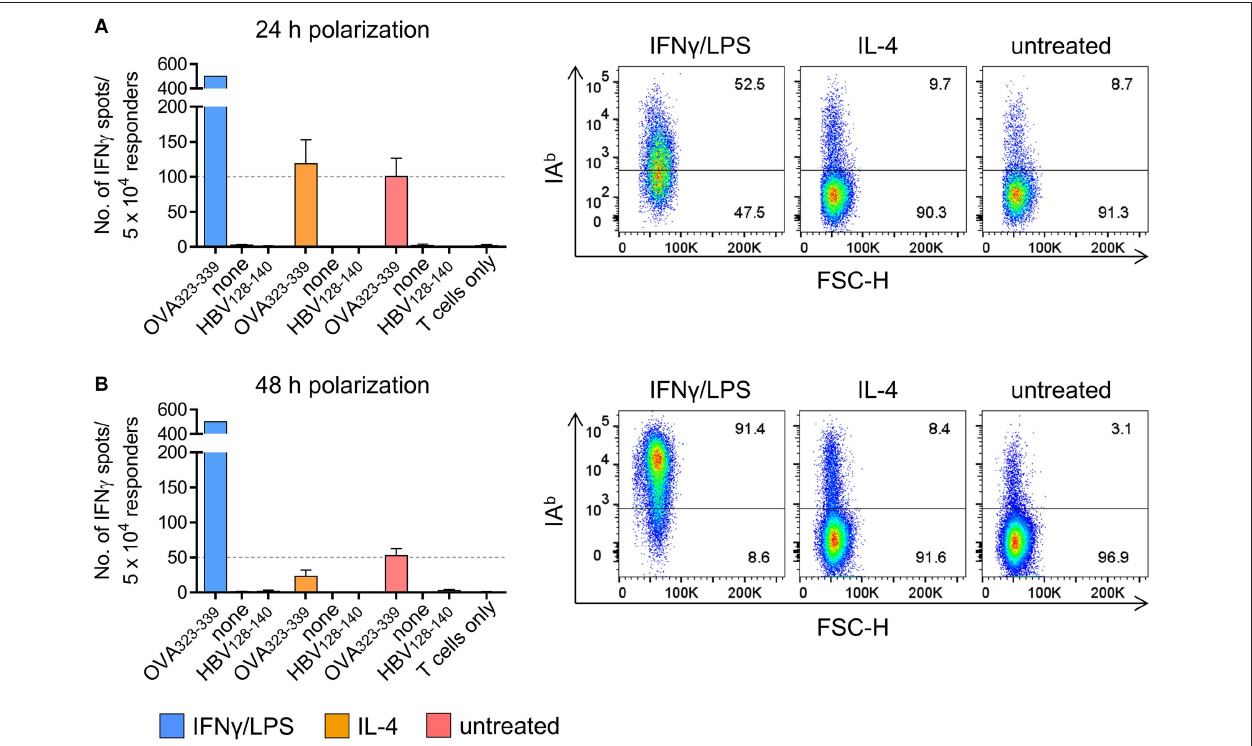
FIGURE 1 | PECs polarized in vitro are susceptible to CD4 + T cell recognition. PECs were either left untreated or incubated with IFN γ /LPS or IL-4 to induce M1 or M2 polarization, respectively. Following incubation for 24h (A) or 48h (B) , PECs were pulsed with IA b restricted epitope OVA 323 − 339 or with HBV 128 − 140 control epitope or were left without peptide (“none”). PECs were then co-cultured with an OVA-specific CD4 + T cell line for 24h and T cell reactivity was analyzed by IFN γ ELISpot assay (left) . IA b surface expression of PECs was determined by FACS (right) . Gating strategy: living cells → single cells (FSC-A vs. FSC-H) → F4/80 + CD11b + → IA b vs.